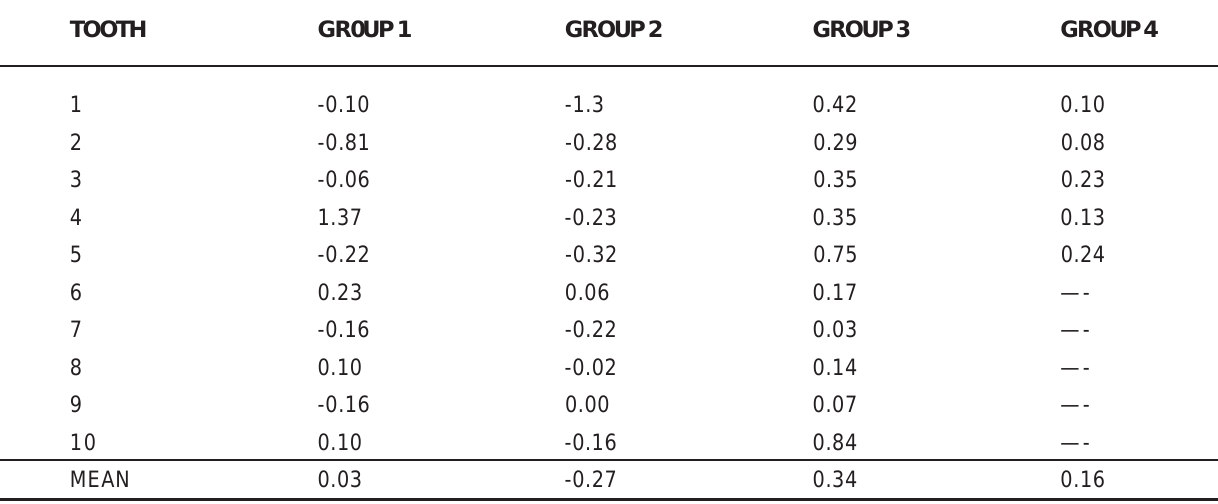
ANOVA - F = 4.97 p = 0.0055 Negative sign indicates lower pH at 60 days than at 30 days.